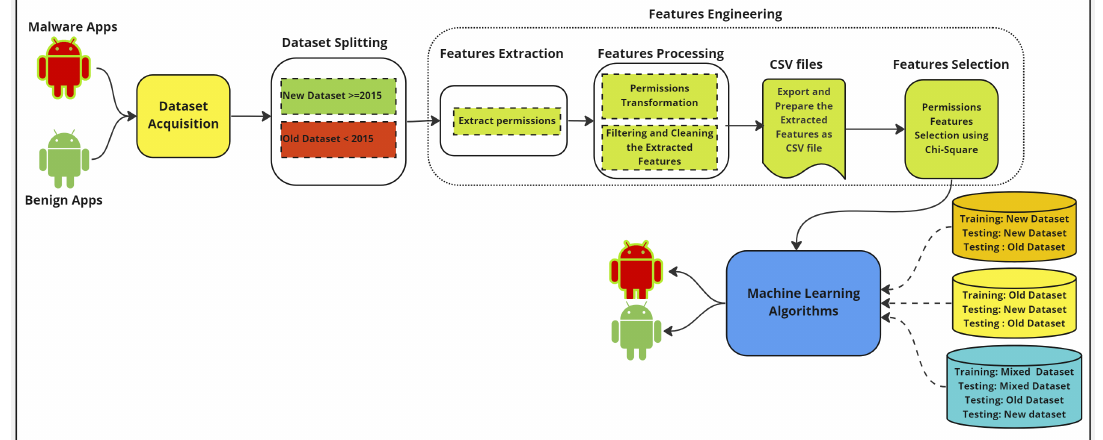
Figure 3. The methodology of the proposed